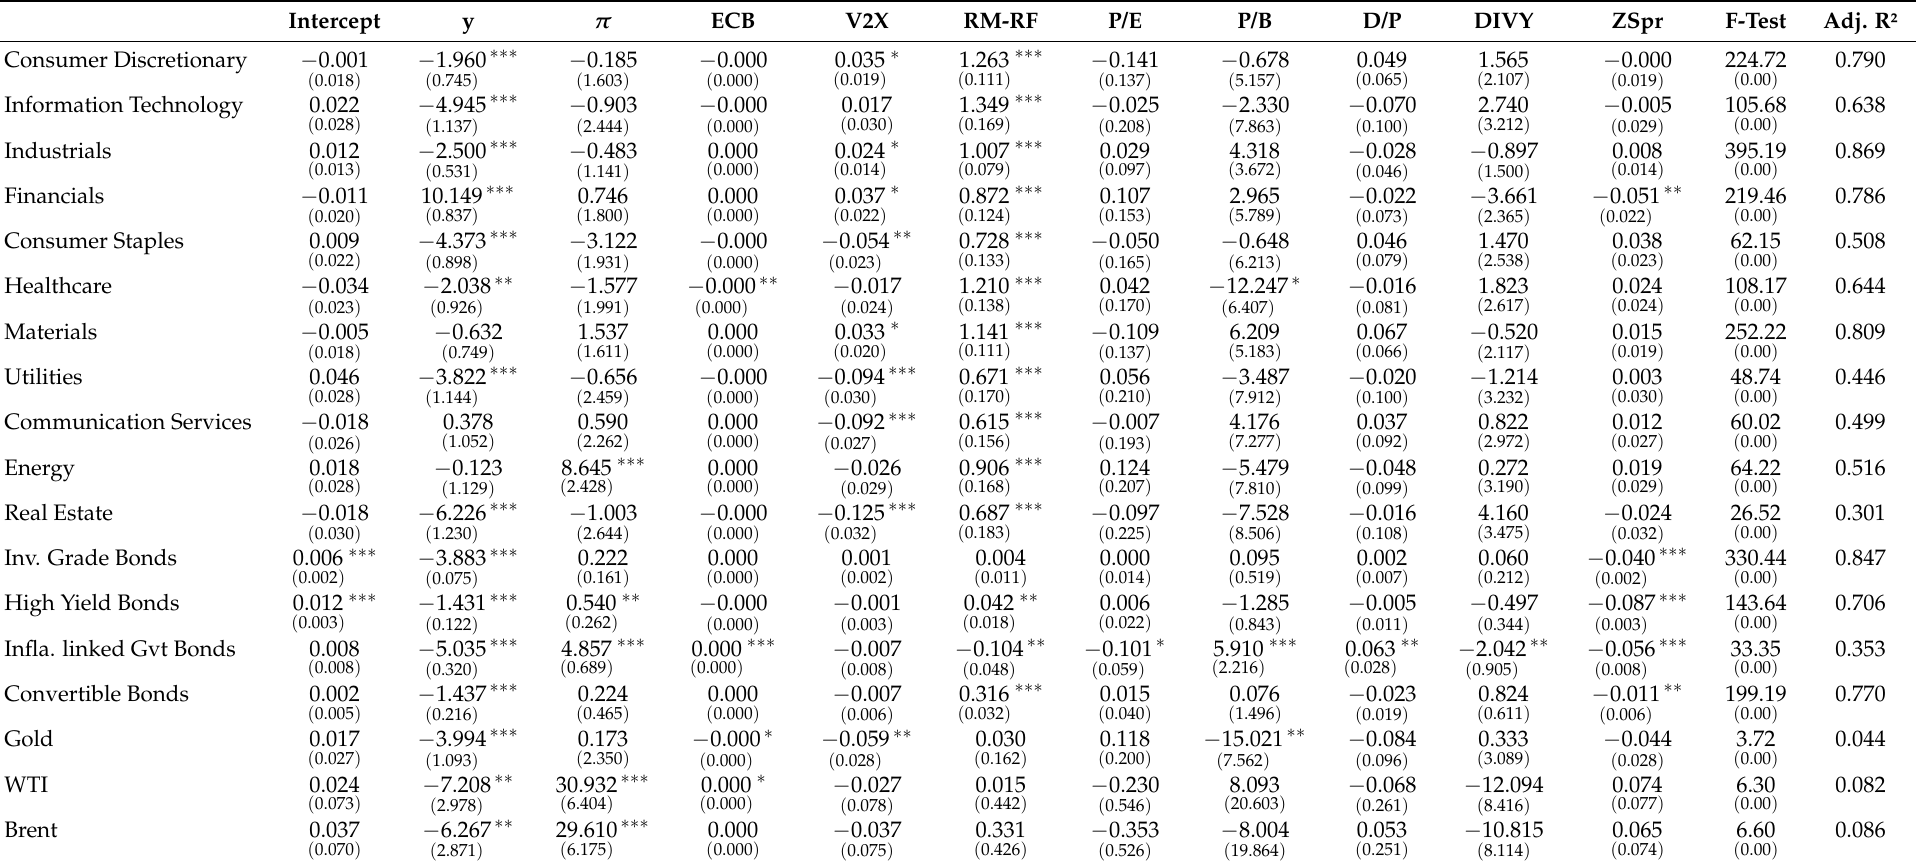
Table A3. Results of regressions conducted for our cross-asset panel for the low volatility regime of inflation expectations from 13 January 2017 to 25 February 2019. Error estimates are indicated in parentheses except for the F-Test, for which the p -value is in